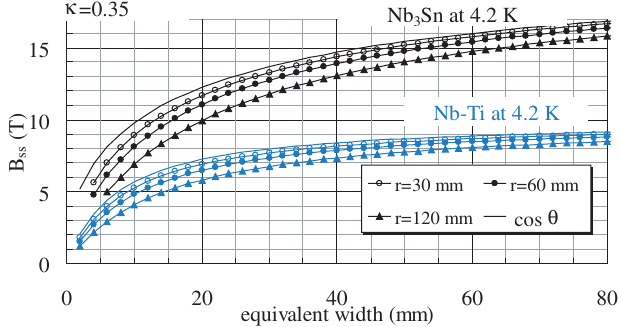
FIG. 7. (Color) Short sample field versus equivalent width ac- cording to (22) and (24) for (cid:5) (cid:1) 0 : 35 .